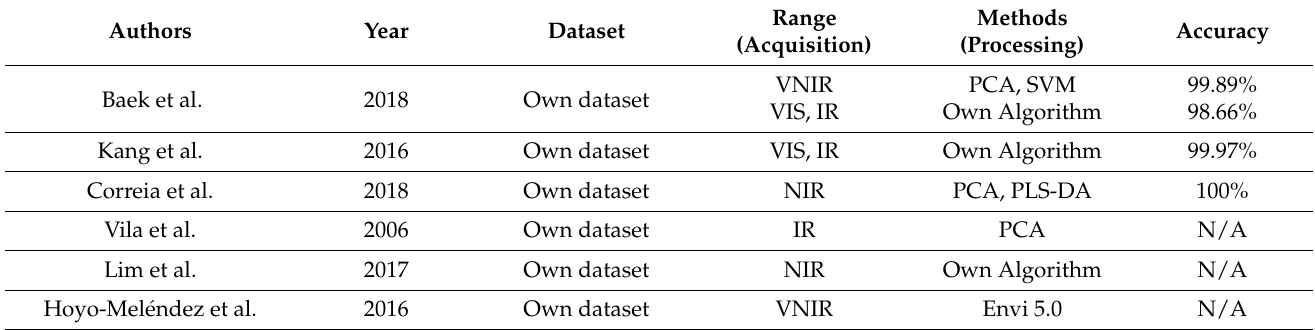
Table 3. Comparison of studies